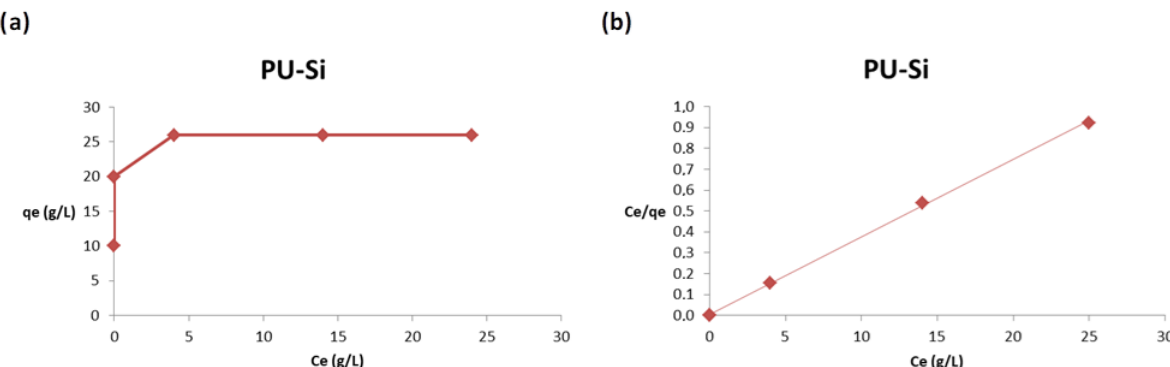
Figure 8. ( a ) Effect of the initial concentration on the adsorption capacity, q, ( b ) Langmuir plot.